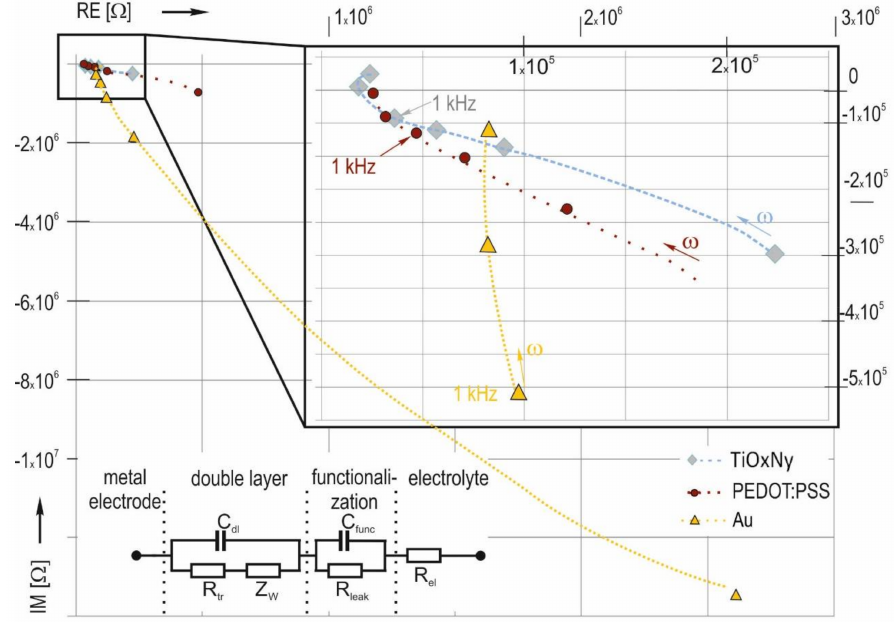
Figure 7. Nyquist plot for thick film gold electrodes, pure and coated with PEDOT:PSS and TiO x N y . The data points represent the median values of all measurements, captured on the test chips: PEDOT:PSS and TiO x N y MEA type A, MEA type C. The equivalent circuit encompasses: R el —electrolyte resistance; C dl —double layer capacitance; R tr —charge transfer resistance; Z W —Warburg impedance; C func —functional layer capacitance; R leak —functional layer leak